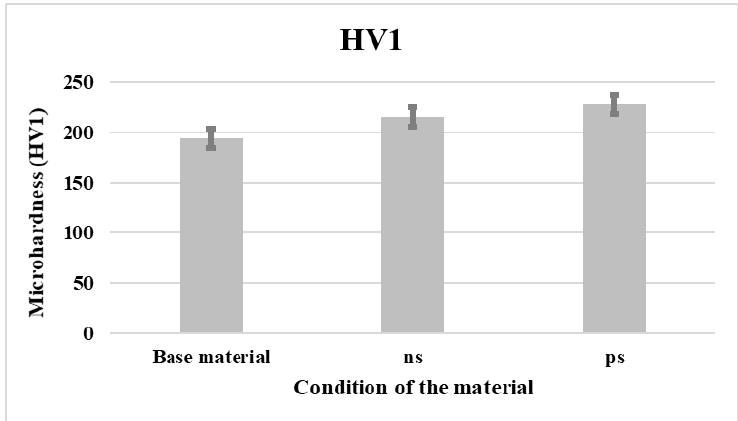
Figure 5. Diagram of microhardness values depending on material condition before deformation and after ns and ps laser